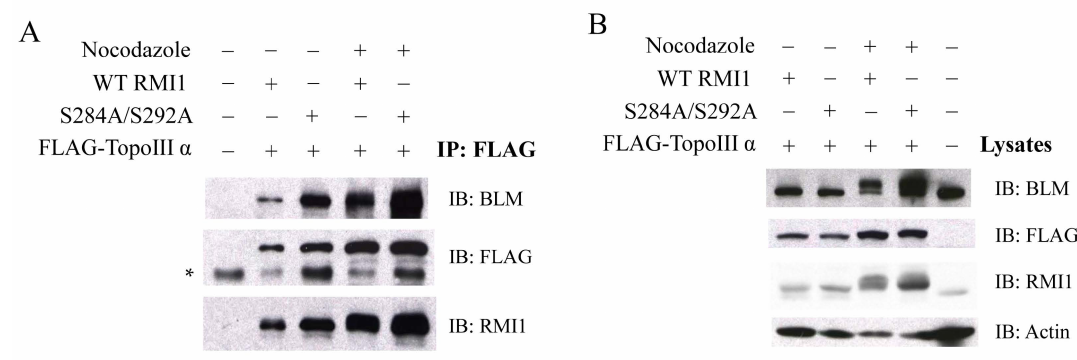
Figure 5. Phosphorylation of RMI1 at Ser284 and Ser292 does not disrupt the interaction between RMI1, TopoIII α and BLM. 293T cells were transfected with FLAG-tagged Topo III α plus Xpress-tagged WT or phospho-mutant (S284A/S292A) RMI1, or GFP expression construct to monitor transfection efficiency, and serve as a negative control (all “ ´ ”). Thirty-two hours after transfection, the cells were subjected to nocodazole treatment for 16 h or not as indicated. ( A ) Whole cell extracts were incubated with FLAG-affinity gel. The precipitates were immunoblotted with anti-RMI1, anti-BLM and anti-FLAG antibodies. * Non-specific bands; ( B ) 40 µ g of whole cell lysates were analyzed by western blot indicating the input proteins in IP.